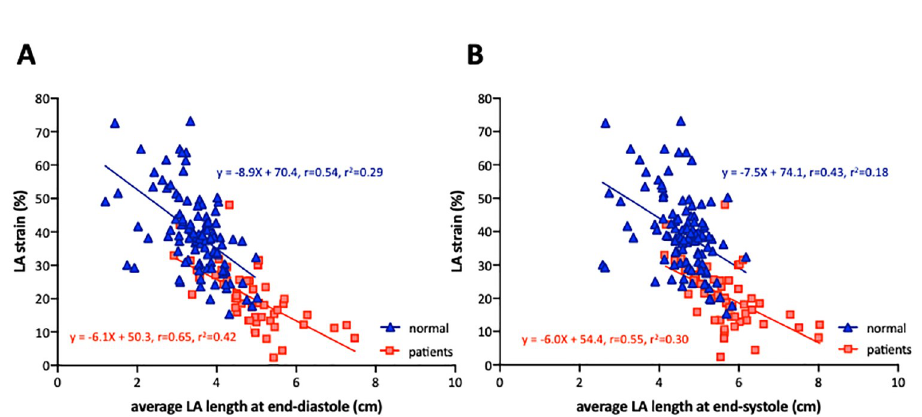
Fig 7. Correlations between biplane LA strain and LA length in patients with cardiovascular disease (n = 53). A: A linear correlation between average left atrial length at end-diastole and biplane left atrial longitudinal strain. B: A linear correlation between average left atrial length at end-systole and biplane left atrial longitudinal strain. Red rectangles represent patients. Data from normal subjects are superimposed (blue triangles).